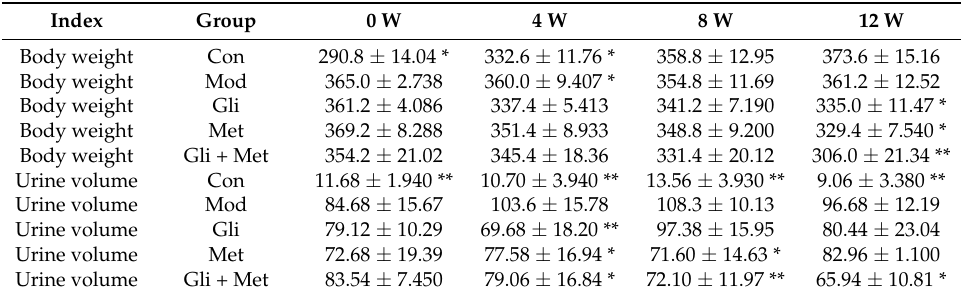
Table 1. The changes in body weight (g) and urine volume (mL) of Zucker diabetic fatty (ZDF) rats.